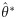
Speed-up of estimated optimal grid configuration with the conditional subsample algorithm compared to the pairwise algorithm.Comparison of simulations using the CS algorithm with θ^* as cell-size threshold, with the pairwise algorithm for different outbreak stages. The y-axis indicate how many times faster (based on run time) the simulations using the CS algorithm were compared to the pairwise simulations.